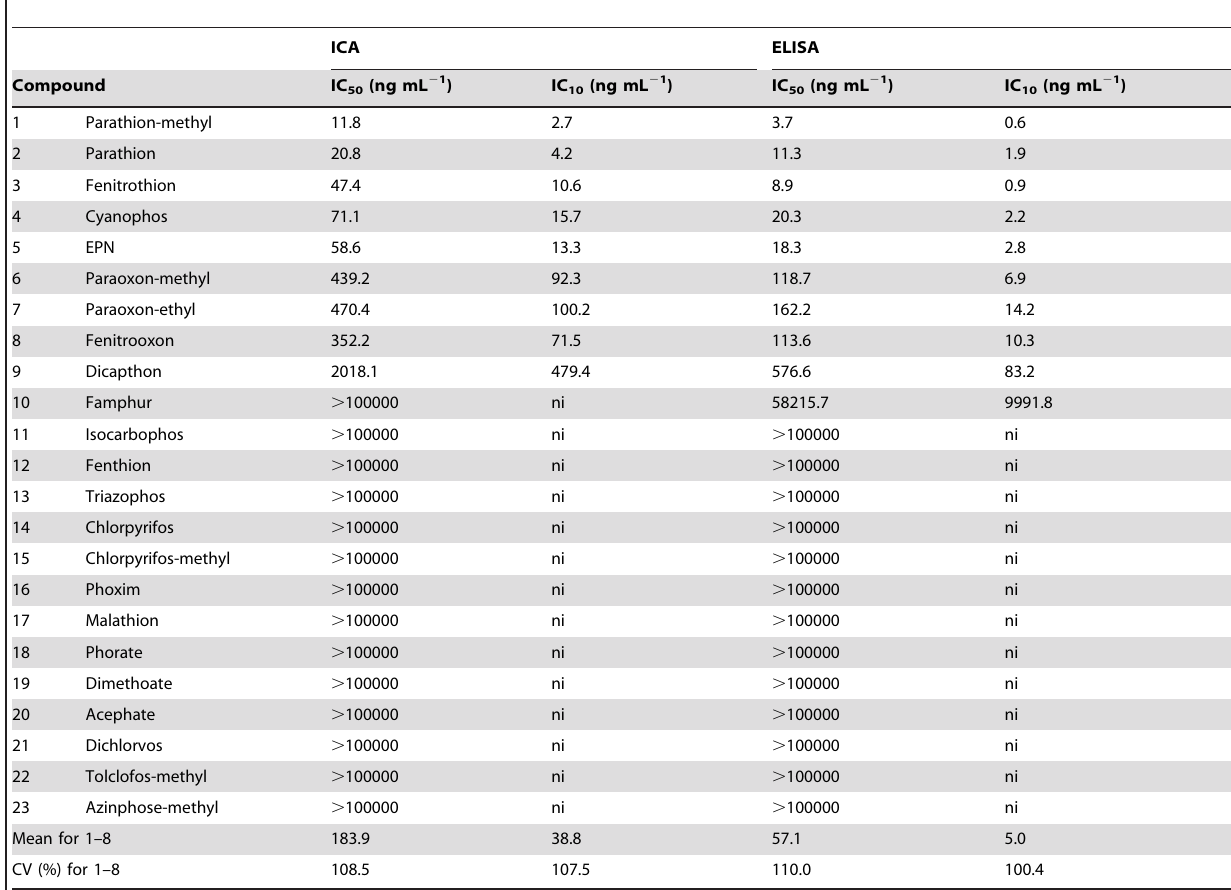
Table 1. IC 50 values and LOD (IC 10 ) of a set of analogs related to parathion-methyl by multi-analyte ICA and